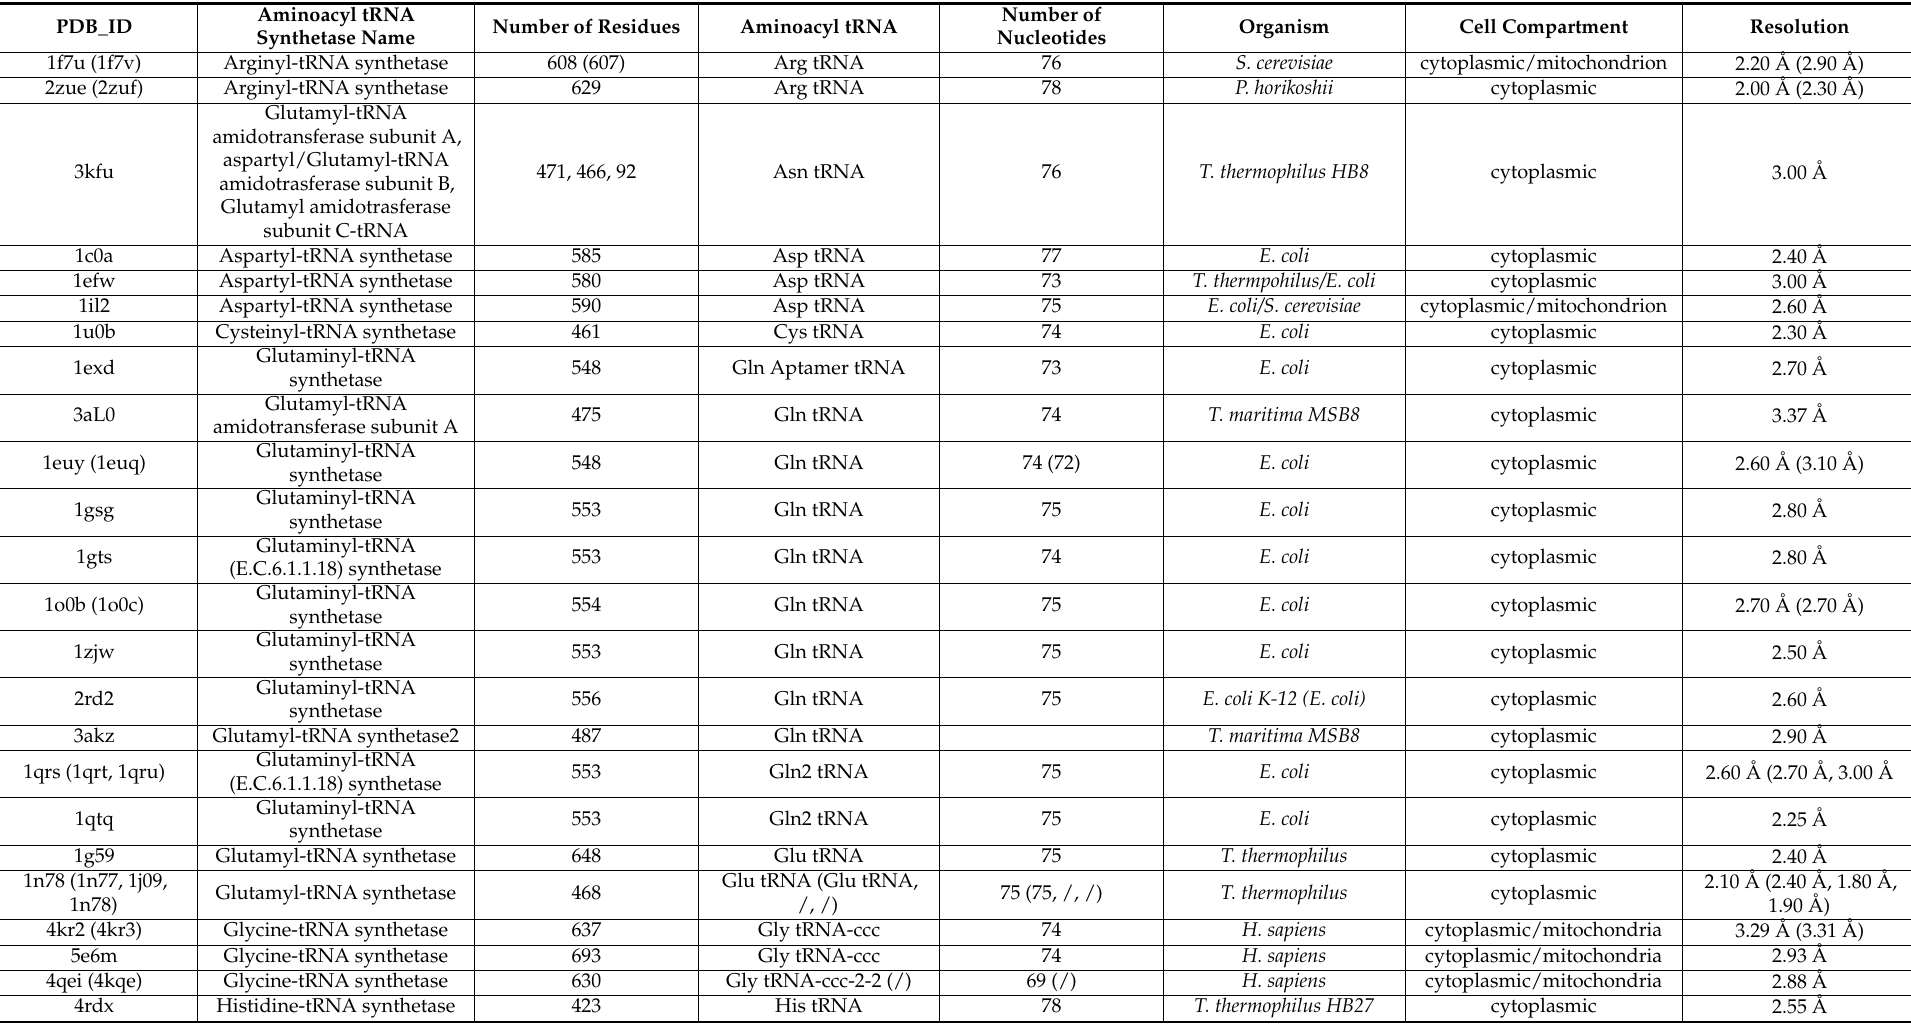
Table 6. List of the aminoacyl tRNA synthetases crystallized in complex with a transported amino